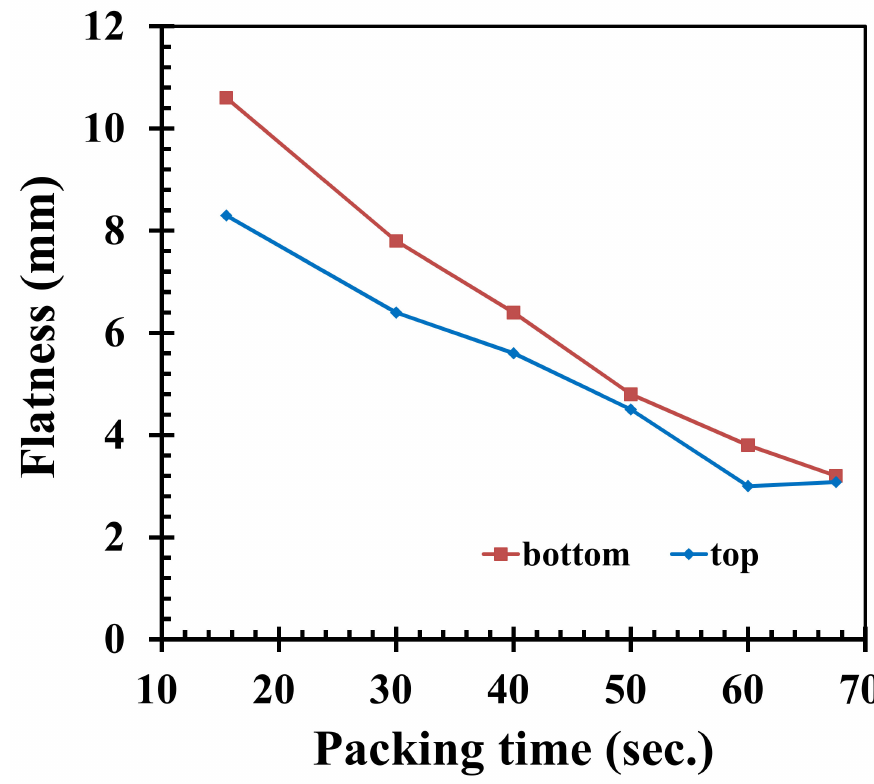
Figure 8. Influence on flatness when lengthening the packing time and shortening the cooling